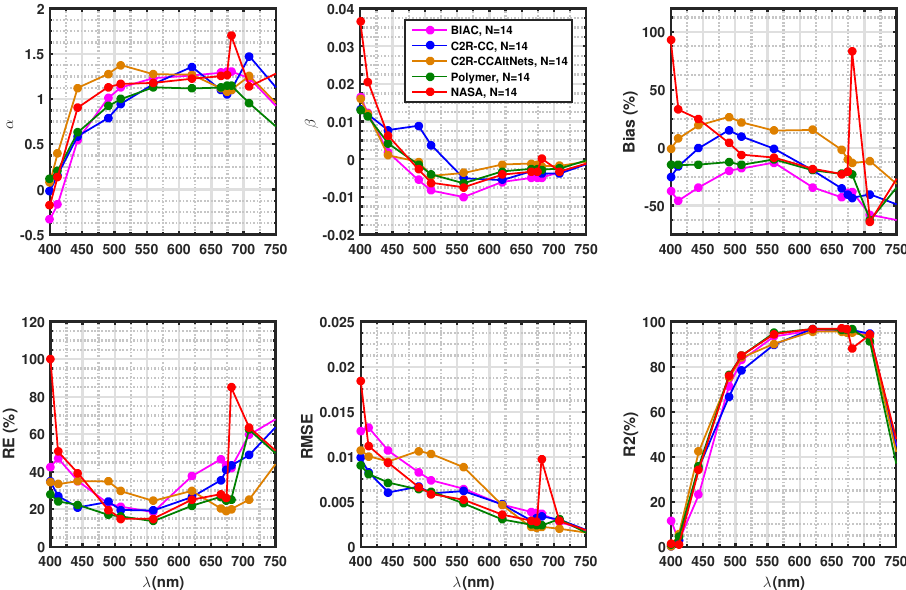
Figure 6. Statistical properties of the AC concomitant match-ups evolution as a function of wavelength between 400 and 750 nm. The statistical properties: slope ( α ), intercept ( β ), bias, relative error (RE), root mean squared error (RMSE), and correlation coefficient ( R 2 ) are represented in the y-axes in the subplots starting from the left-top subplot until the right-bottom subplot, respectively. The x-axes represents the variation of the wavelength between 400 and 750 nm. The color code is similar to that in Figure 3 and given with the match-ups numbers in the top-middle subplot text